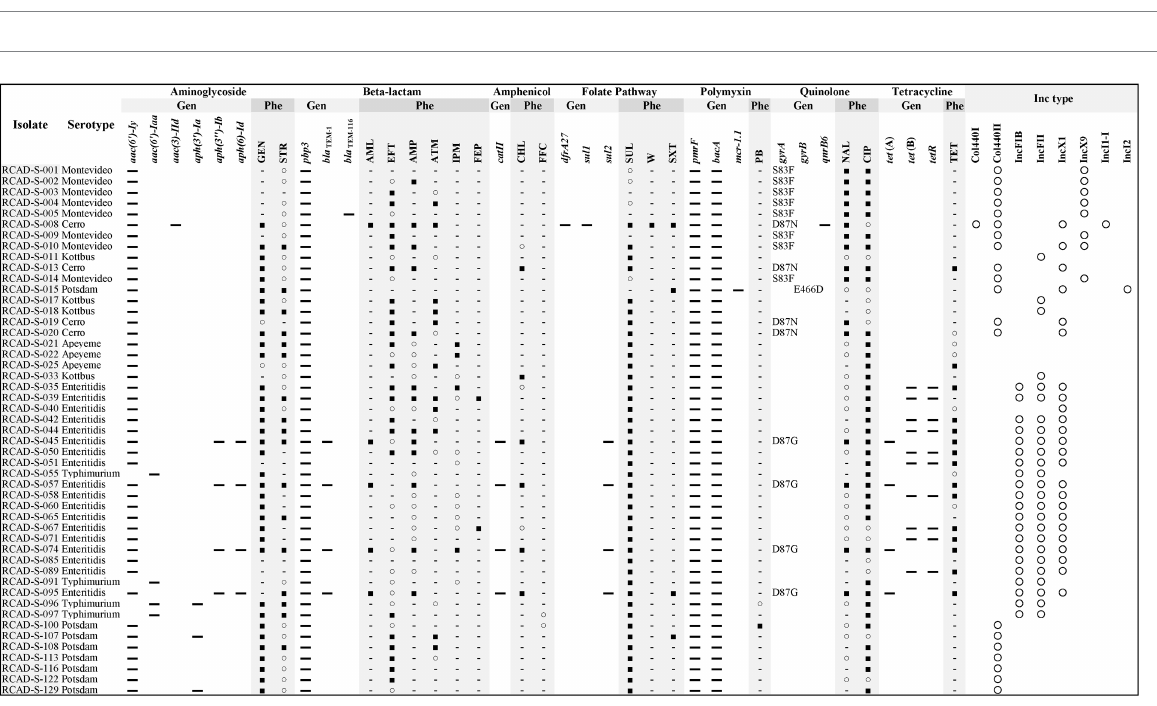
FIGURE 2 Comparison of antimicrobial resistance (AMR) profiles and plasmid replicons of the 49 Salmonella isolates. For the gyrA and gyrB genes, mutation sites are shown. Gen, genotype; Phe, phenotype; and Inc. type, incompatible type. ▬ , Hit resistance gene; ■ , resistant; ○ , susceptible, increased exposure; − , susceptible, standard dosing regimen; and ○ , hit plasmid replicons. SUL, sulfadiazine; CIP, ciprofloxacin; GEN, gentamycin; EFT, ceftiofur; TET, tetracycline; AMP, ampicillin; STR, streptomycin; ATM, aztreonam; NAL, nalidixic acid; IPM, imipenem; SXT, trimethoprim/ sulfamethoxazole; AML, amoxicillin; CHL, chloramphenicol; FEP, cefepime; W, trimethoprim; FFC, florfenicol; and PB, polymyxin